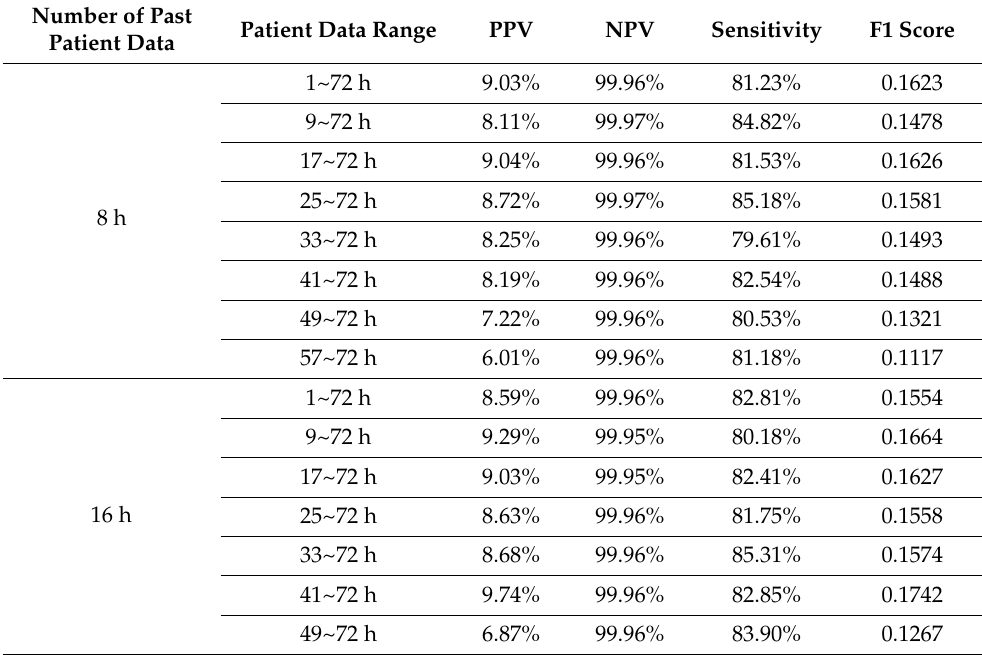
Figure 3. Receiver operating characteristic (ROC) curve of each parameter. Table 8. Performance evaluation of the number of past patient data and patient data